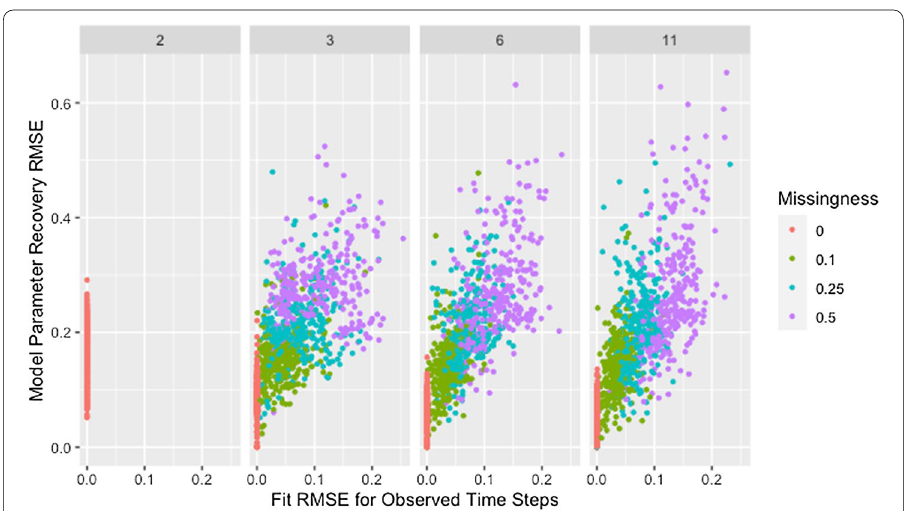
Fig. 8 RMSE for model parameter recovery by fit RMSE, missingness, and time steps. RMSE for known and predicted weights by RMSE for observed and predicted opinions on observed time steps, proportion of missing data, and number of time steps across